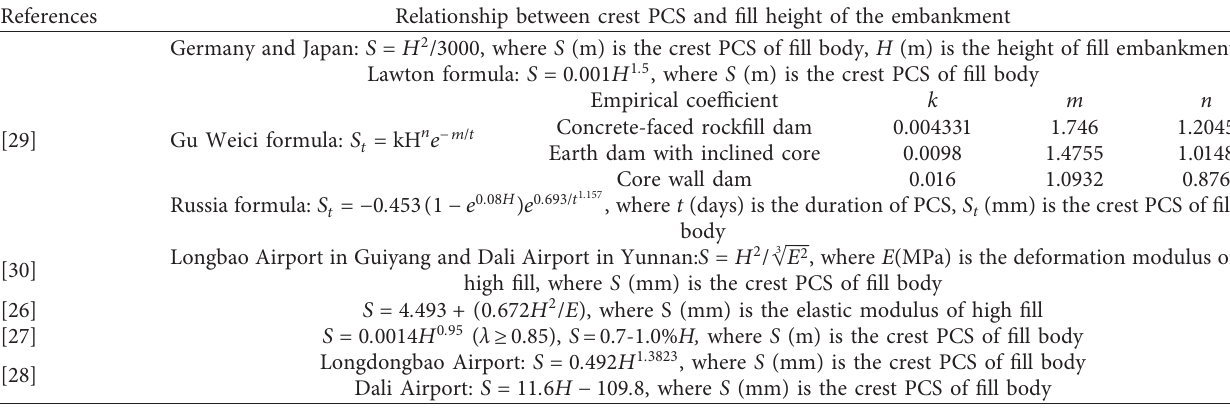
Table 1: PCS estimation formulas of fill embankment from case studies. Relationship between crest PCS and fill height of the embankment Germany and Japan: S � H 2 /3000, where S (m) is the crest PCS of fill body, H (m) is the height of fill